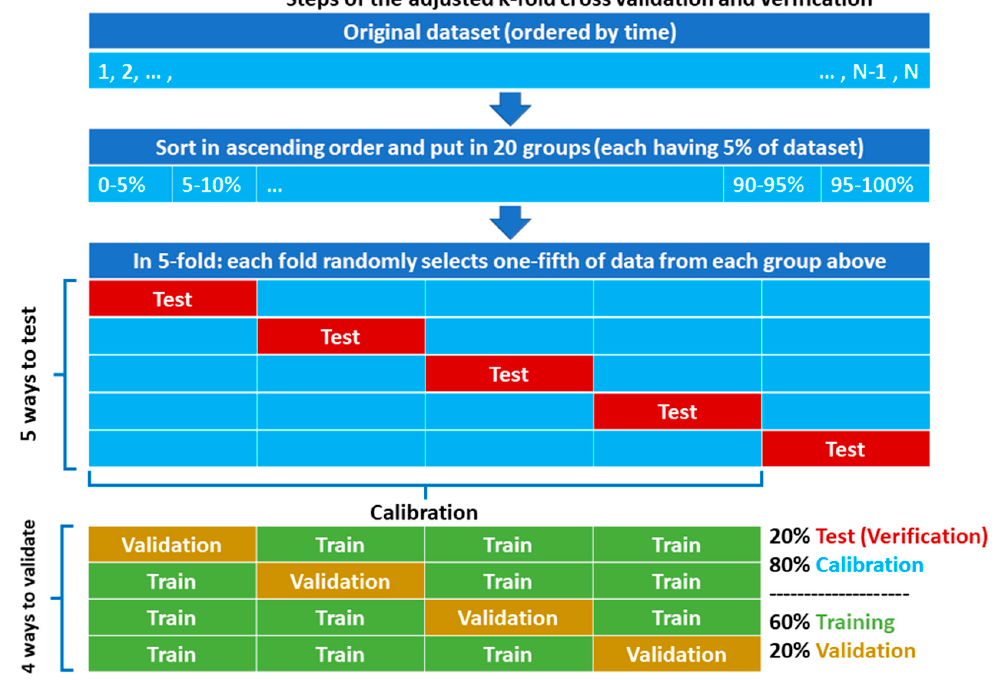
Figure 3. Schematic of the dataset grouping and partitioning with the adjusted k -fold process.